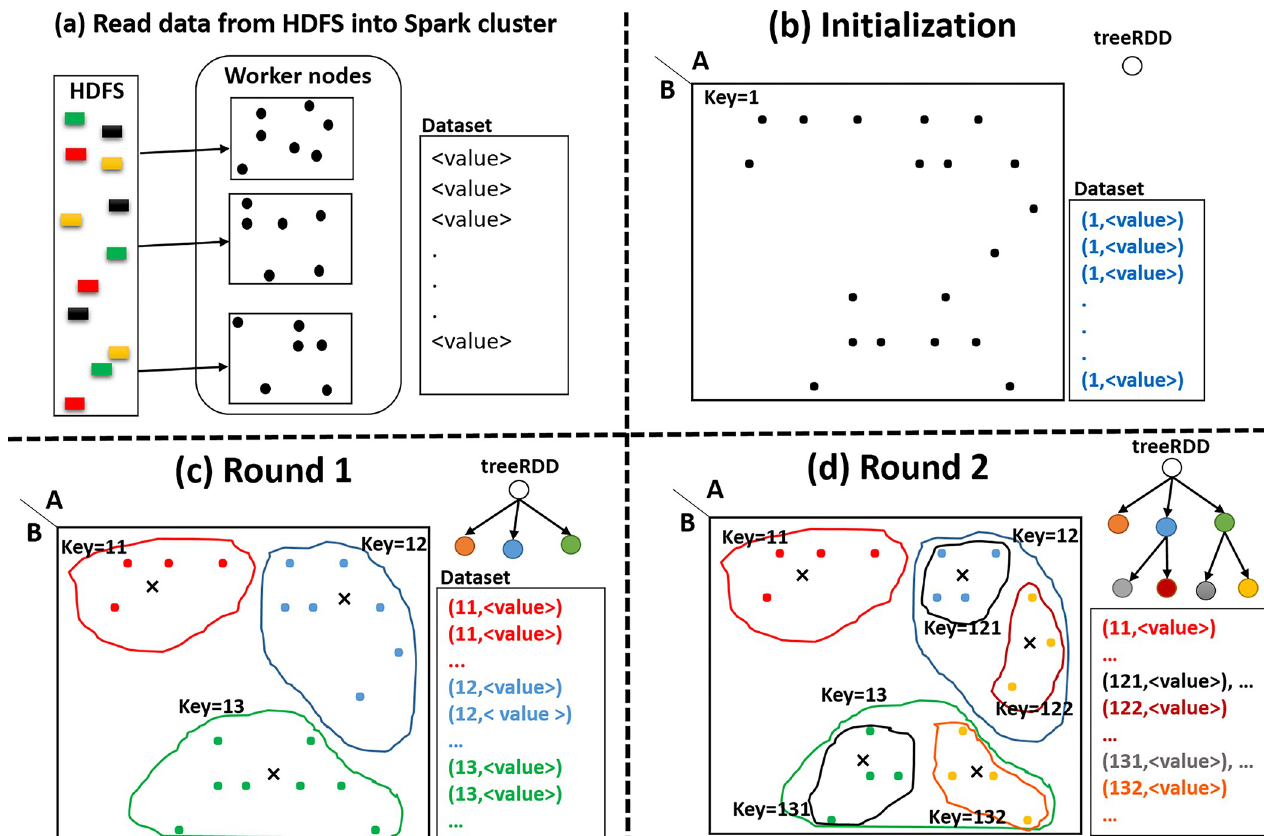
Fig 4. Schema of hierarchical data clustering in Spark framework: (a) reading dataset from HDFS into worker nodes. (b) Assigning a unique key to all recrods. (c) The first round of data clustering and forming sub-clusters. (d) The second round of data clustering and forming smaller sub-clusters.